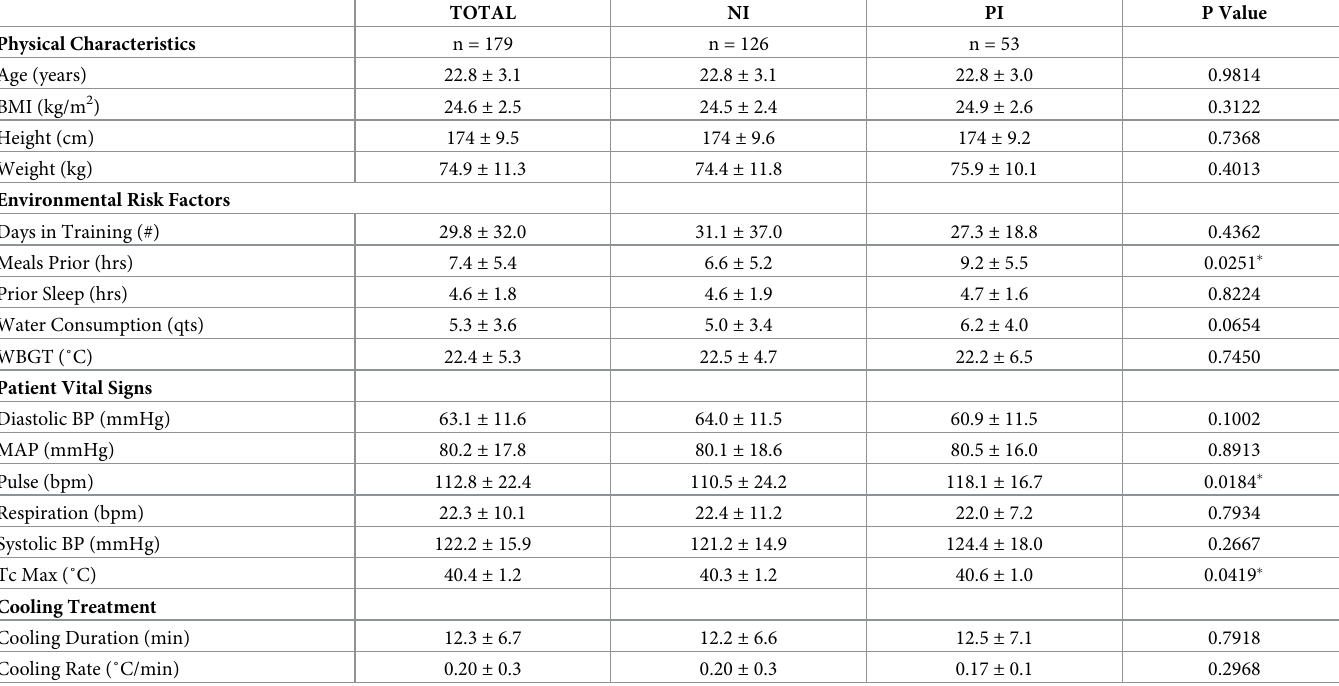
Table 1. EHS Patient Characteristics, Vital Signs, and Risk Factors Taken at the Point of Care.